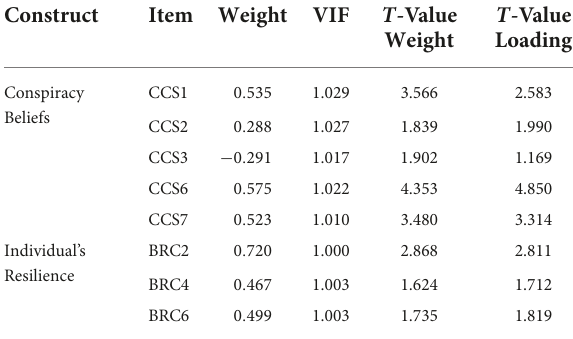
TABLE 5 Convergent validity (formative